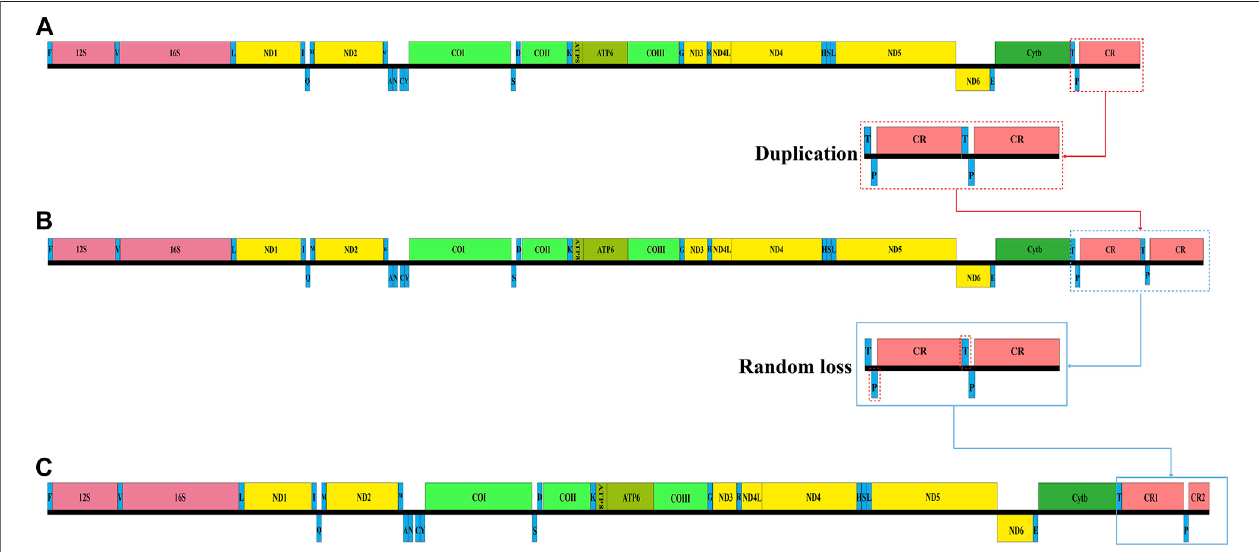
FIGURE 5 | Analysis of Garra mitochondrial gene rearrangement. (A) The typical mitochondrial genome organization in Garra . (B) The normal mitochondrial gene blocks ( T-P-CR ) form gene blocks ( T-P-CR-T-P-CR ) after complete duplication. (C) The rearrangement mitochondrial genome organization of Garra species. The replicated CR is left behind in some genes (T and P) that undergo random loss events. F : tRNA-Phe ; V : tRNA-Val ; L : tRNA-Leu ; I : tRNA-Ile ; Q : tRNA-Gln ; M : tRNA-Met ; W : tRNA-Trp ; A : tRNA-Ala ; N : tRNA-Asn ; C : tRNA-Cys ; Y : tRNA-Tyr ; S : tRNA-Ser ; D : tRNA-Asp ; K : tRNA-Lys ; G : tRNA-Gly ; R : tRNA-Arg ; H : tRNA-His ; S :